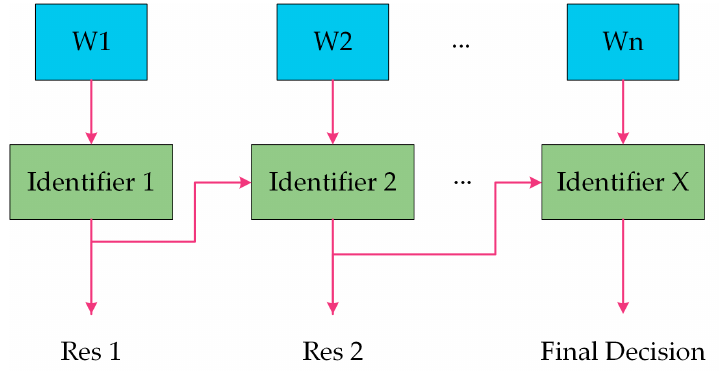
Figure 2. Block diagrams of the AdaBoost algorithm.